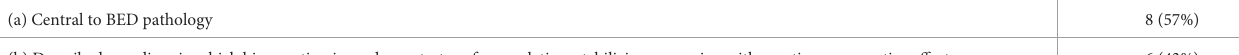
TABLE 10 Participant statements consistent with theme 3, subtheme iii, “emotion regulation and negative urgency”. Subtheme (iii) Emotional regulation & negative